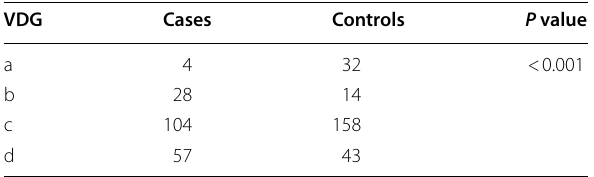
Table 6 Association